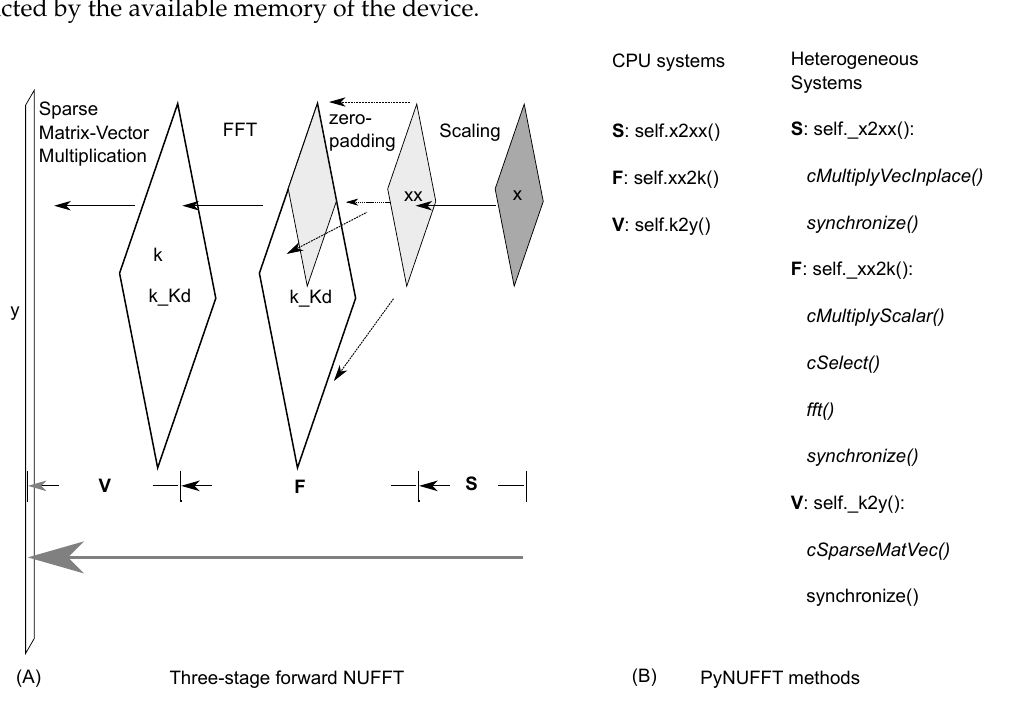
Figure 2. ( A ) A two-dimensional example of the forward PyNUFFT; ( B ) The methods provided in PyNUFFT. Forward NUFFT can be decomposed into three stages: scaling, fast Fourier transform (FFT), and